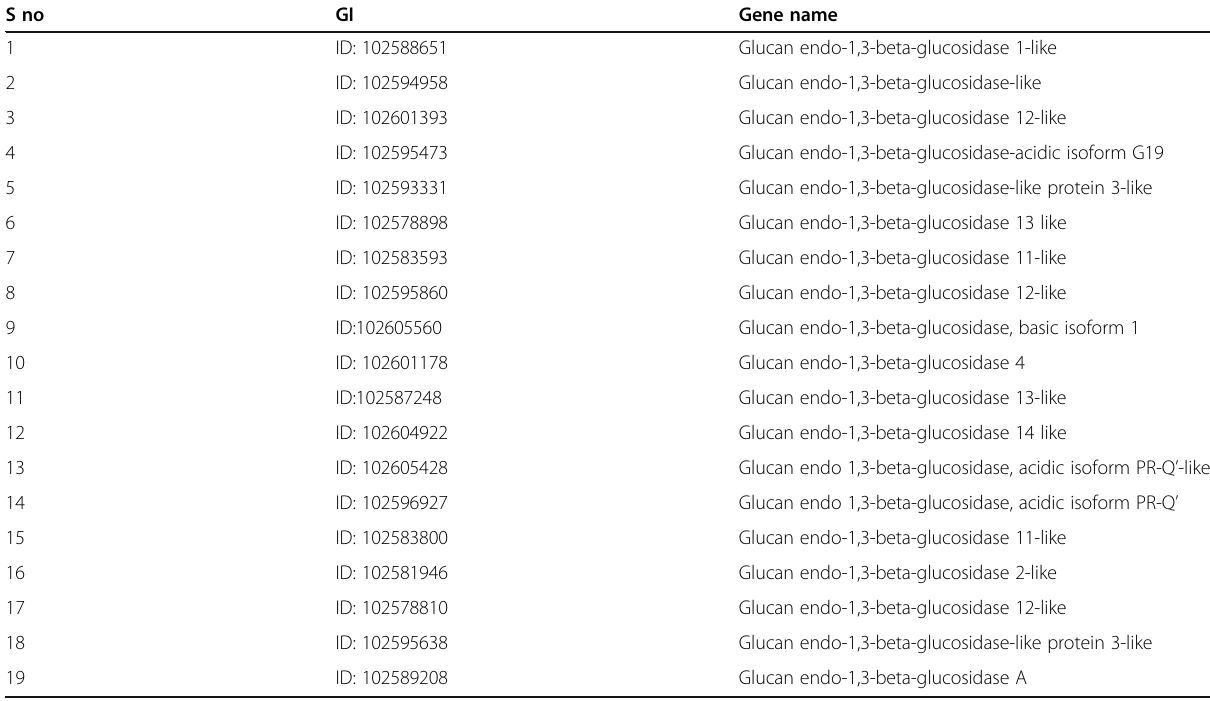
Table 1 List of the glucan endo-1,3-beta-glucosidase genes of Solanum tuberosum cultivar DM1-3 156R44 selected for